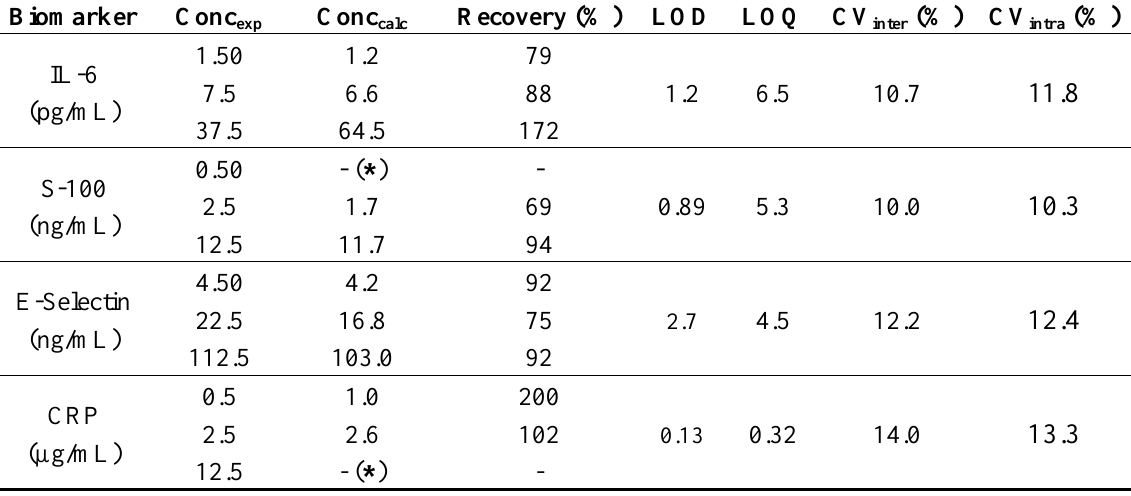
Table 3. Recoveries, LODs, LOQs and inter- and intra-array variabilitiy for the optimized low volume